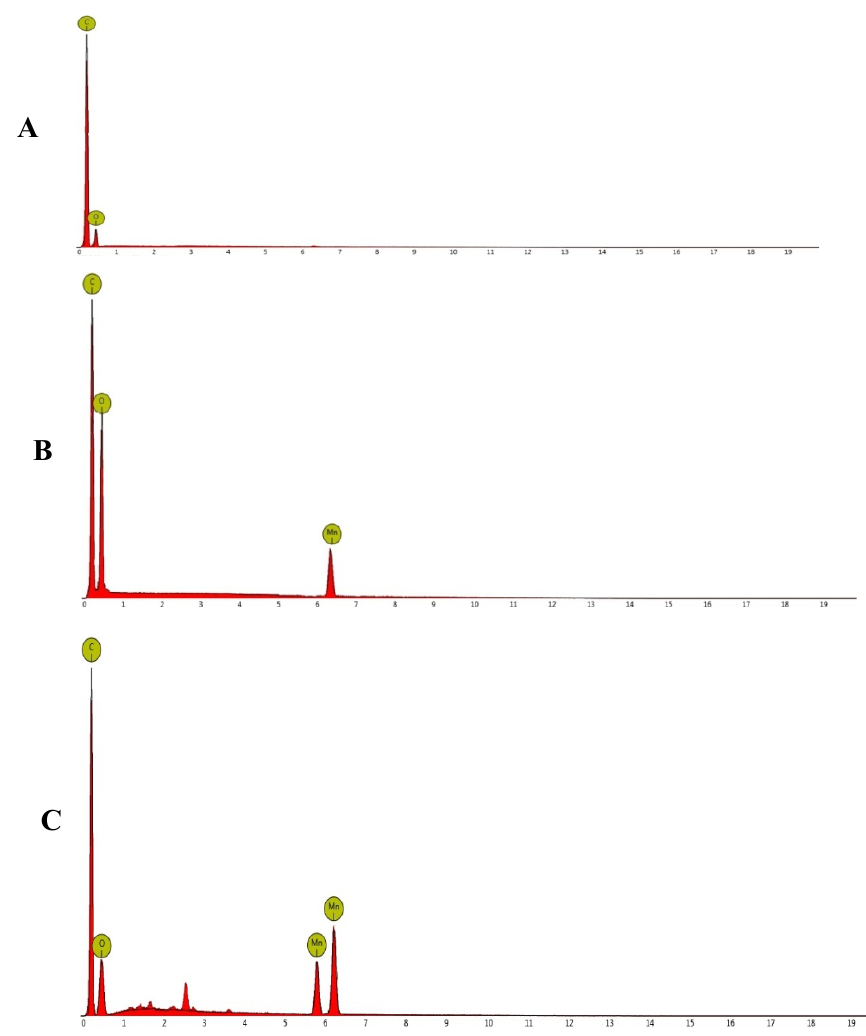
Fig. 3. EDS of a) raw active carbon, b) impregnated active carbon, and c) impregnated